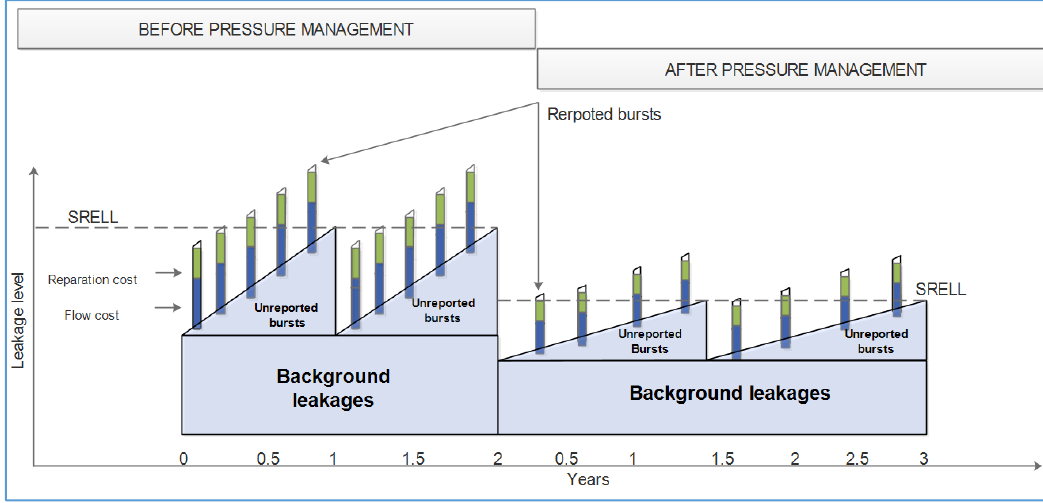
Figure 9. Effect of pressure management over the SRELL (modified from [23]).